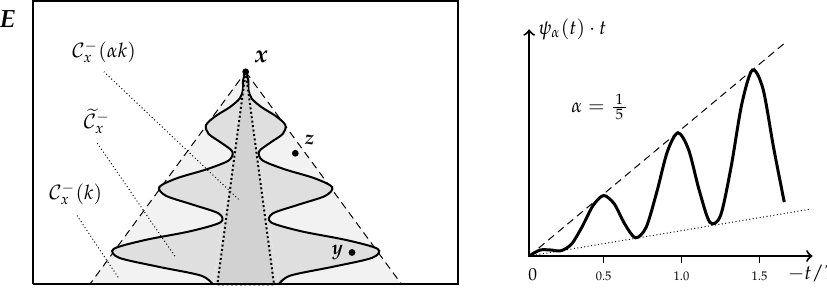
Figure 5. ( Left ): the causal cones C − x and (cid:101) C − x of x ; note that (cid:101) ∆ ( y , x ) < (cid:101) ∆ ( z , x ) = ∞ even if ∆ ( y , x ) > ∆ ( z , x ) . ( Right ): the cross section of (cid:101) C − x , backwards in time, in units of T . The slope of the dashed line is 1 and that of the dotted line is α .